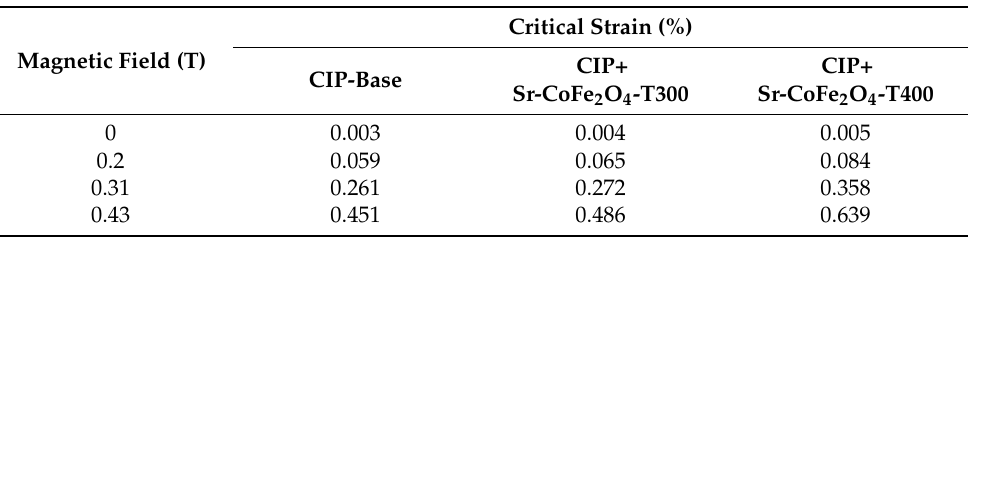
Figure 7. Shear stress curve against magnetic fields of all MRF samples.